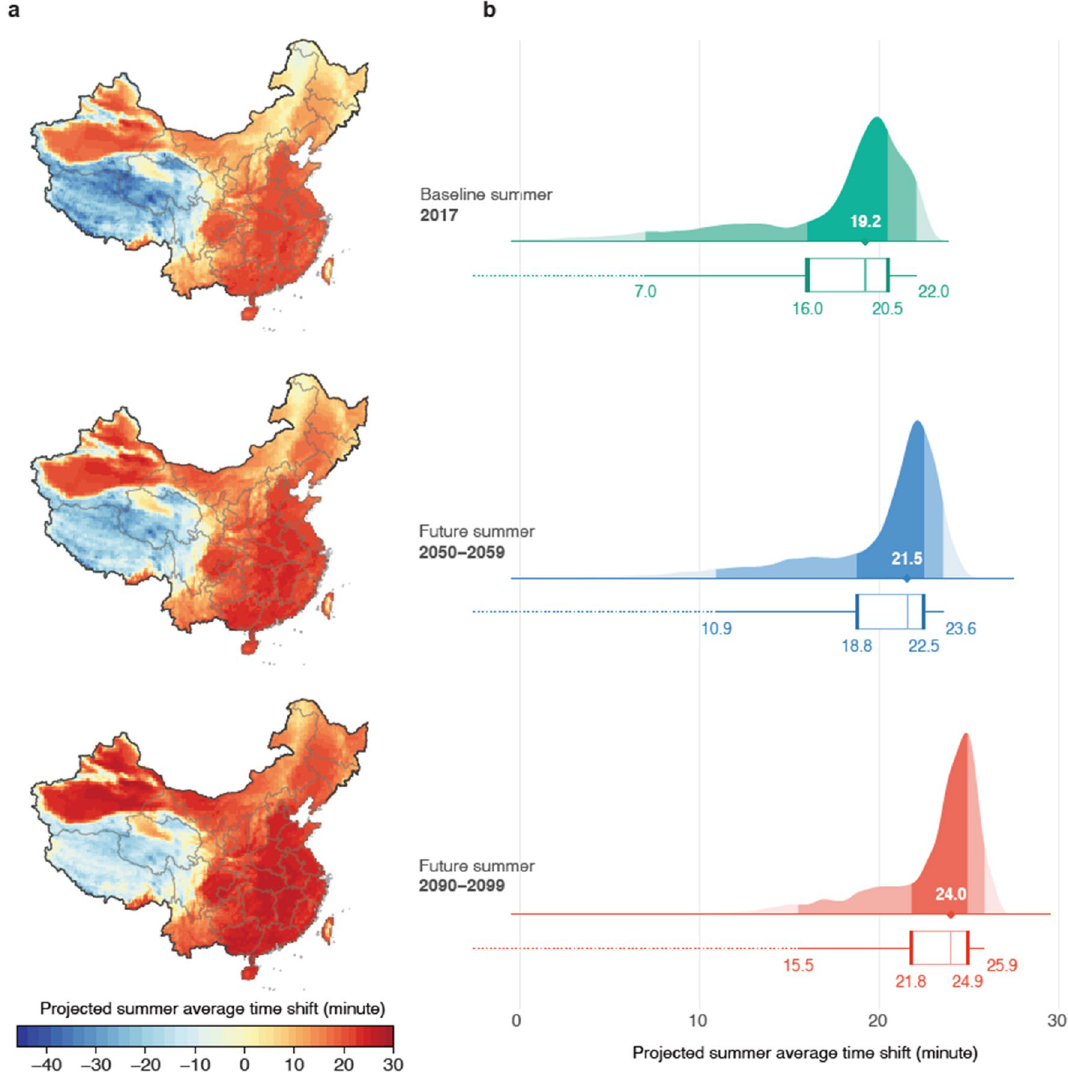
Figure 6. Projected time shift in intraday timing of activity in summer. ( a ) Geographic distribution of average yearly activity time shift due to temperature in 2017, at mid-century (2050–2059) and end of the century (2090–2099) under RCP8.5 scenario. ( b ) Size of populations subjecting to each yearly average time shift levels. Density plots how the distribution of time shifts across the population, and box plots show median, interquartile range (i.e., 25–75%) and 95% confidence intervals. The results displayed in each row are in 2017, at mid-century (2050–2059), and end of the century (2090–2099) under the RCP8.5 scenario. Results for yearly average of all seasons under RCP8.5 and RCP 4.5 are presented in Supplementary Fig. 7–8. The figure was created using R (version 4.1.0 https:// www.r- proje ct. org/), and the maps do not have a copyright